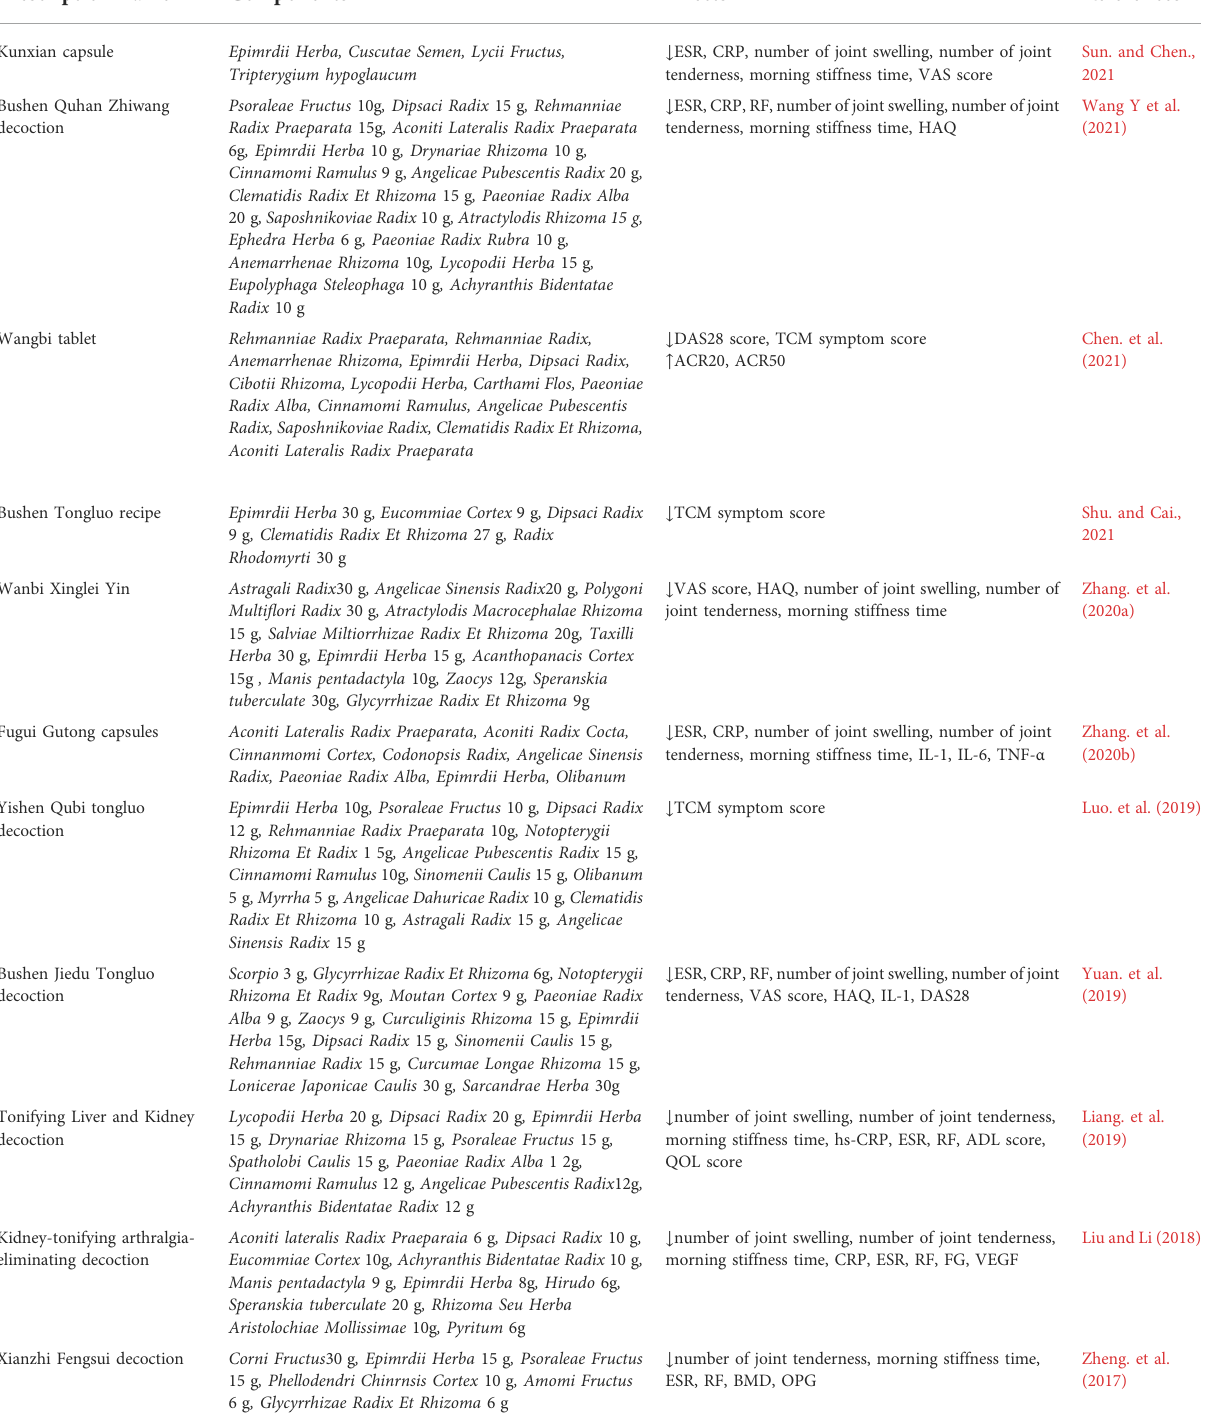
TABLE 1 The prescriptions of TCM containing EH used by physicians for management of